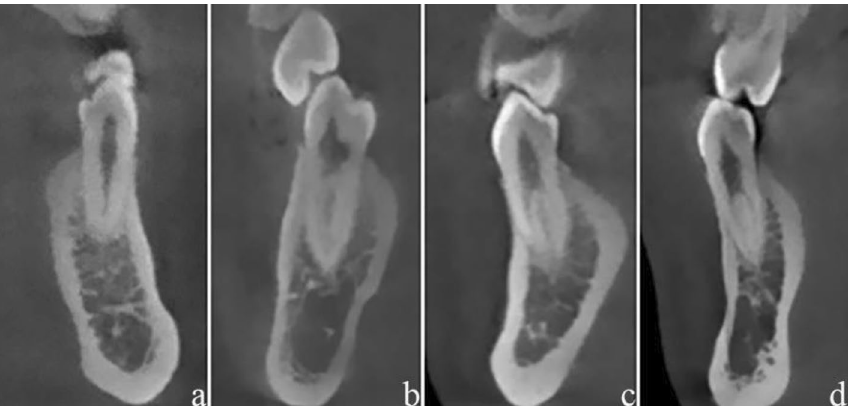
Figure 3. Several examples of root canal system configurations in mandibular premolars according to Vertucci classification ( a : I; b : III; c : V; d : VII).